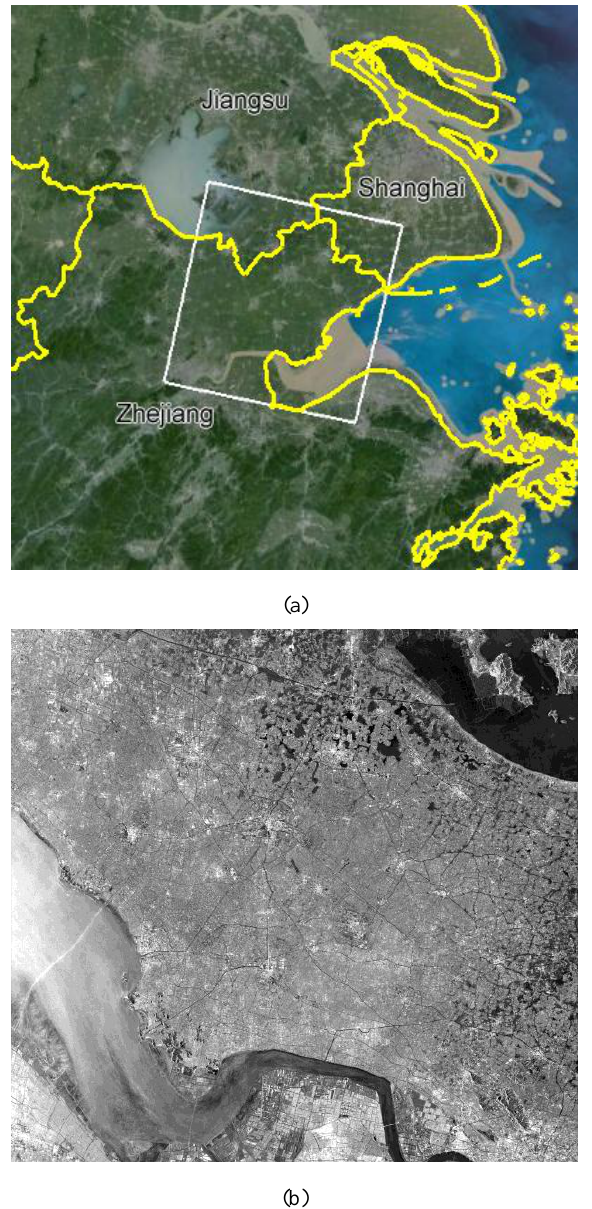
Figure 1. Optical image of study area (provided by Google Earth) (a) and the average amplitude image of 25 ENVISAT ASAR images (b)